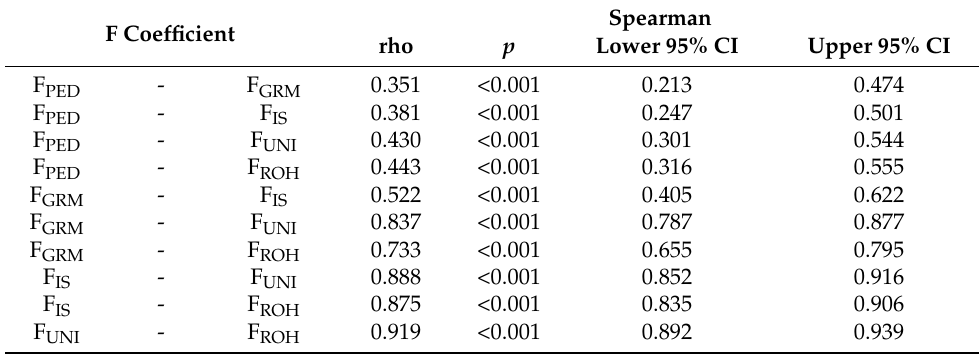
Table 4. Correlation coefficients among all measures of inbreeding.